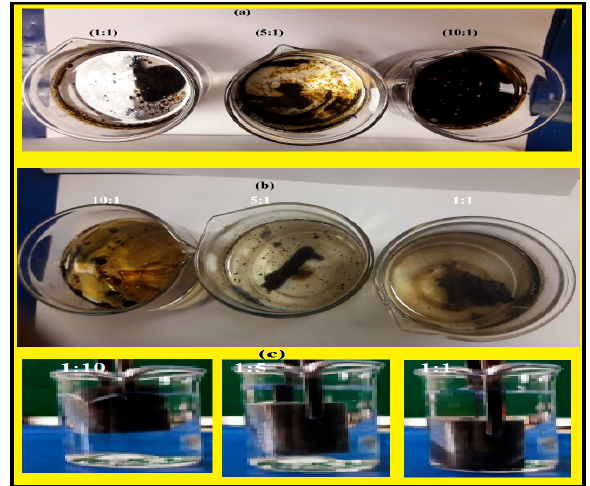
Figure 11. Images showing oil spill collection with ( a ) superhydrophobic sand, ( b ) HSNP-2 (prepared in the presence of 40 wt.% ASAS), and ( c ) PU sponge treated with HSNP-2 (prepared in the presence of 40 wt.% ASAS).